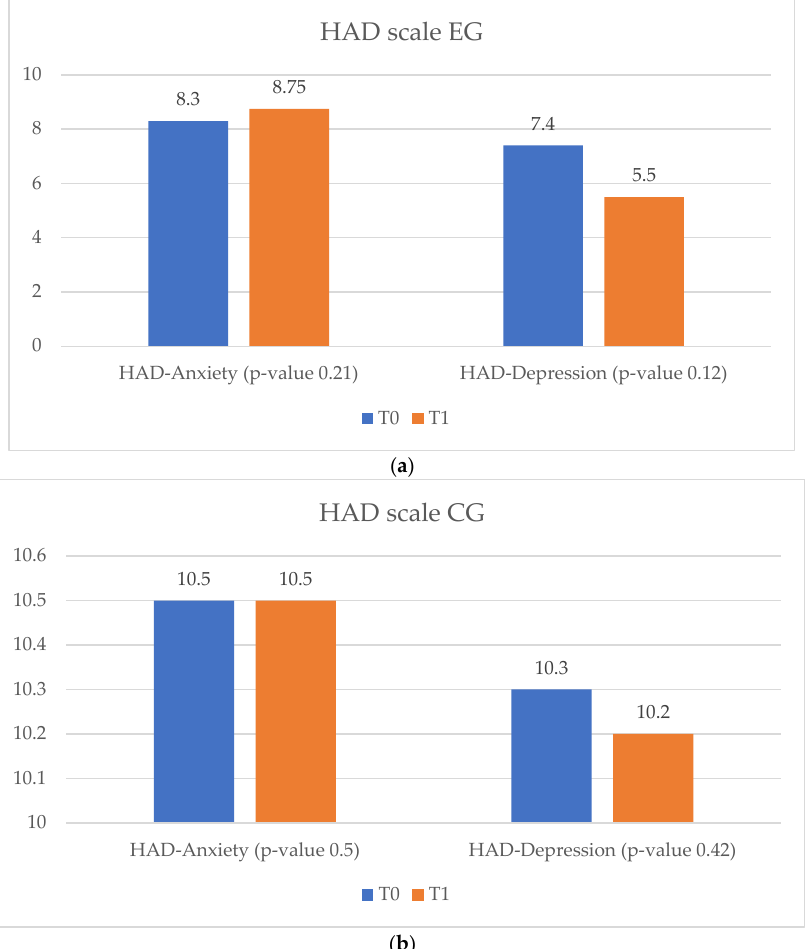
Figure 9. HAD scale results for IHD EG and CG at T 0 and T 1 . ( a ) HAD scale EG. ( b ) HAD scale CG. HAD = hospital anxiety and depression scale; IHD = ischemic heart disease; EG = experimental group; CG = control group; T 0 = before the rehabilitation period; T 1 = after the rehabilitation period.